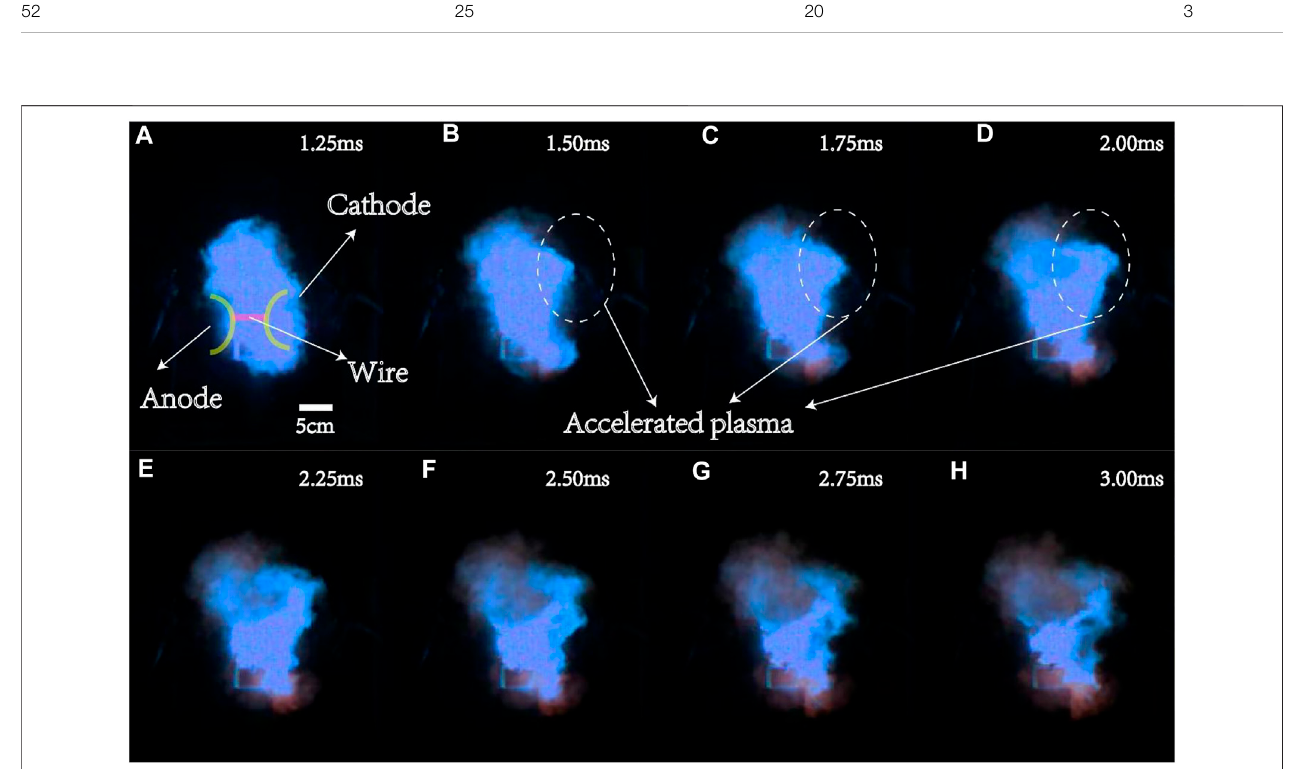
FIGURE 2 | Time-series images of plasma jet evolution for experiment 1. The solid lines show the position of the electrodes in the fi rst image; the plasma acceleration is observed in Panels (B – D) , and the kink instability of plasma is observed in Panels (E, F) .